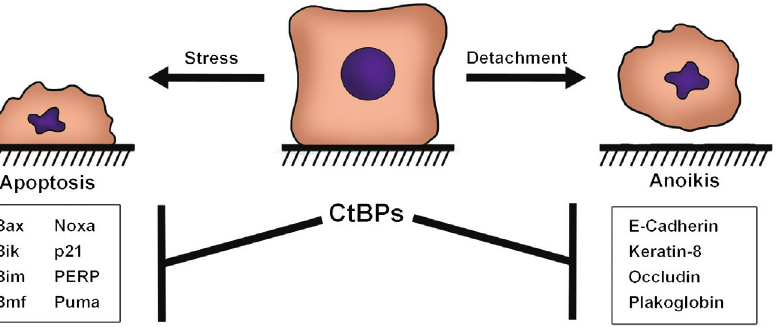
Figure 5 CtBPs as repressors of apoptosis and anoikis gene programming. CtBPs promote cellular survival through transcriptional repression of the pro-apoptotic molecules Bax, Bik, Puma, Noxa, PERP, p21, Bim, and Bmf. CtBPs also repress epithelial gene programming associated with anoikis insensitivity by repression of E-cadherin, occludin, plakoglobin, and keratin